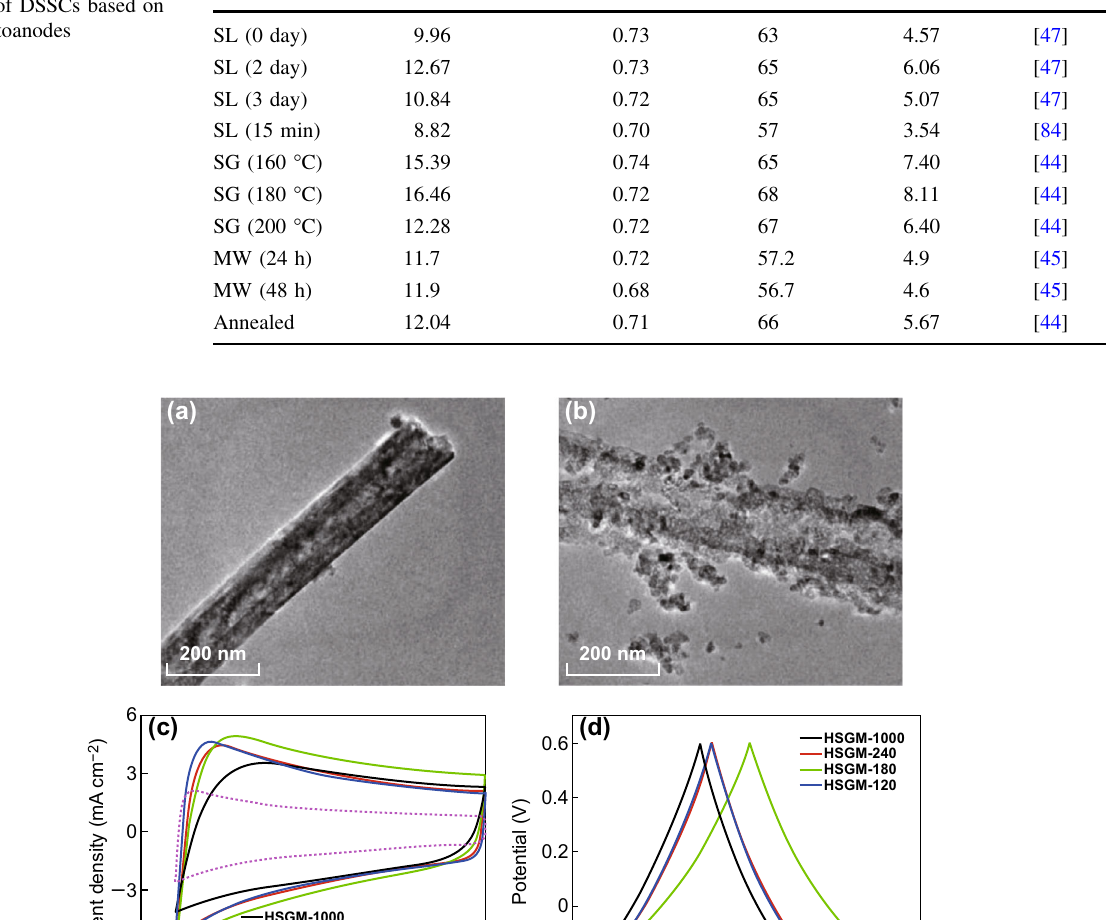
Table 2 Photovoltaic parameters of DSSCs based on various photoanodes